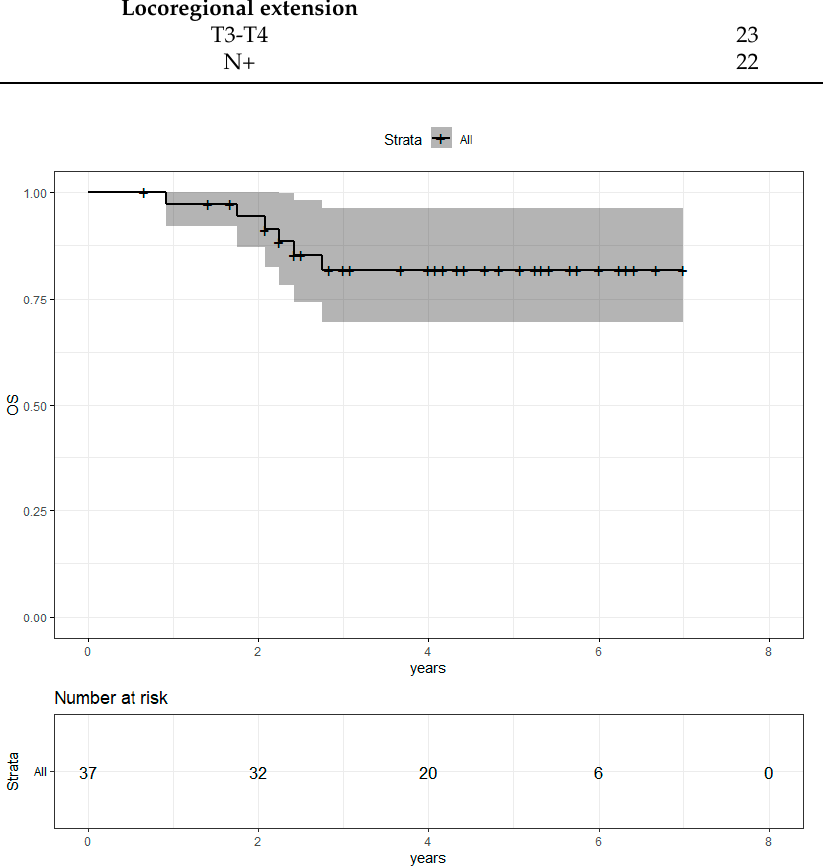
Figure 2. Overall survival of the population with metastatic disease at the time of diagnosis after concomitant RT and Pertu/Trastu dual HER2 blockade. Confidence intervals are provided in grey.